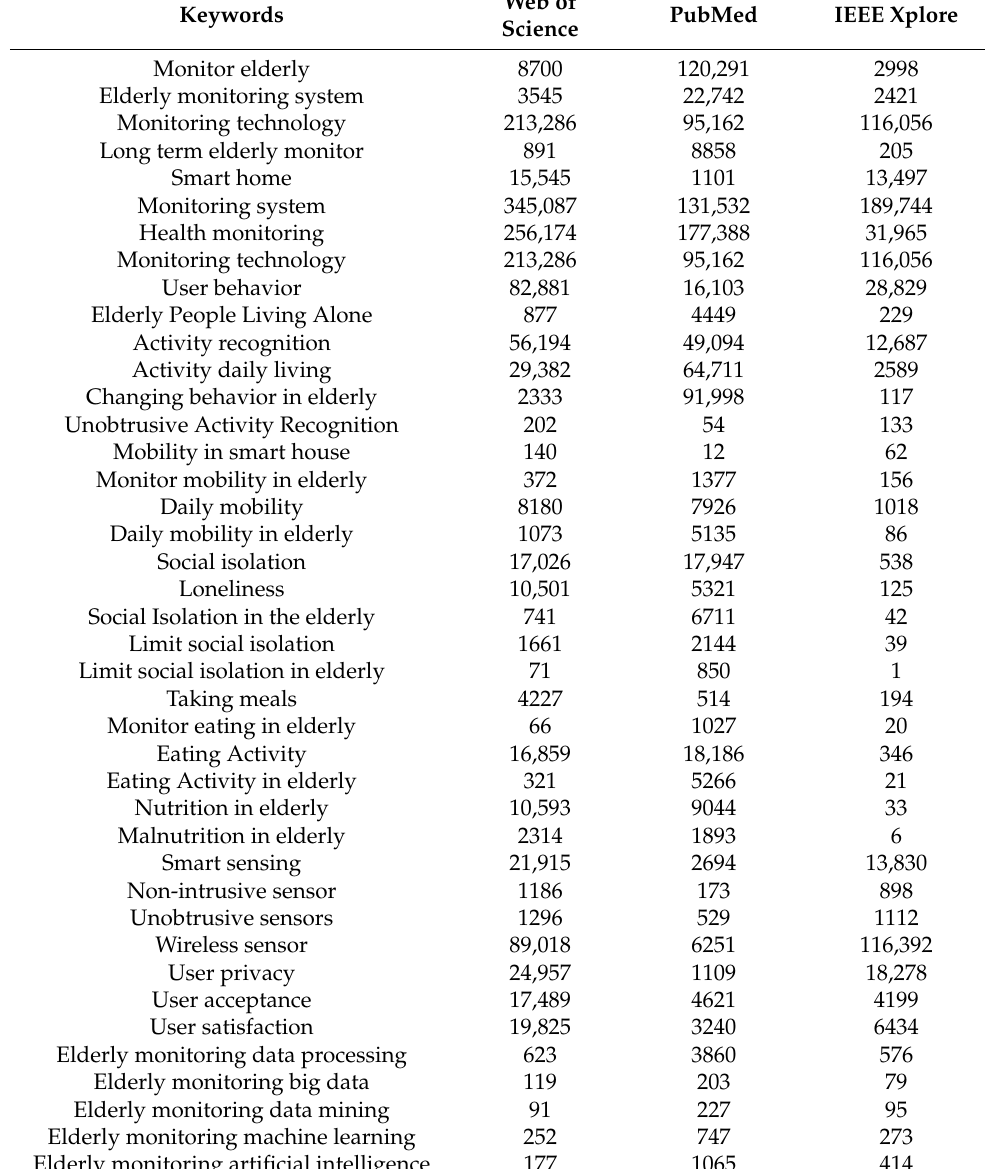
Table 2. Number of hits in the area of sleep monitoring systems research between 2010 and